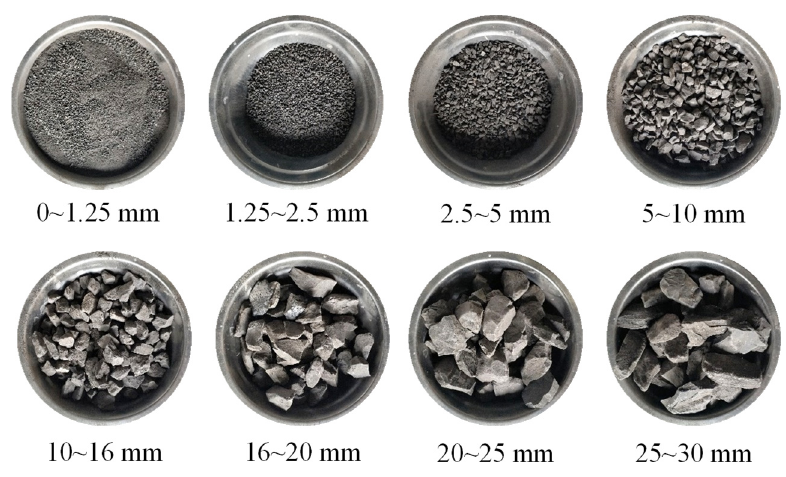
Figure 3. Gangue particles with different